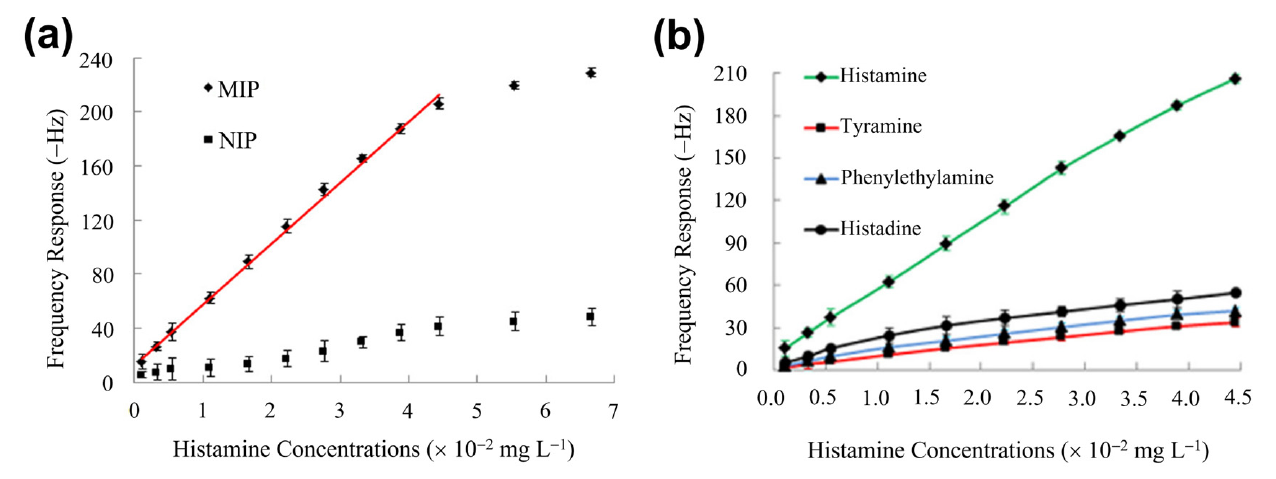
Figure 10. ( a ) Dose–response curve of histamine detection obtained with a quartz-crystal microbalance with a MIP-functionalized QCM chip. The response is linear and shows saturation for higher concentrations [203]. Coatings made of a nonimprinted reference polymer (NIP) cause a weak, nonselective response due to adsorption without molecular recognition. ( b ) QCM crystals functionalized with the histamine–MIP show a small response to competitor molecules in the same order as the NIP signal in panel ( a ). Figures adapted with permission from ref. [203], Copyright 2014, American Chemical Society.